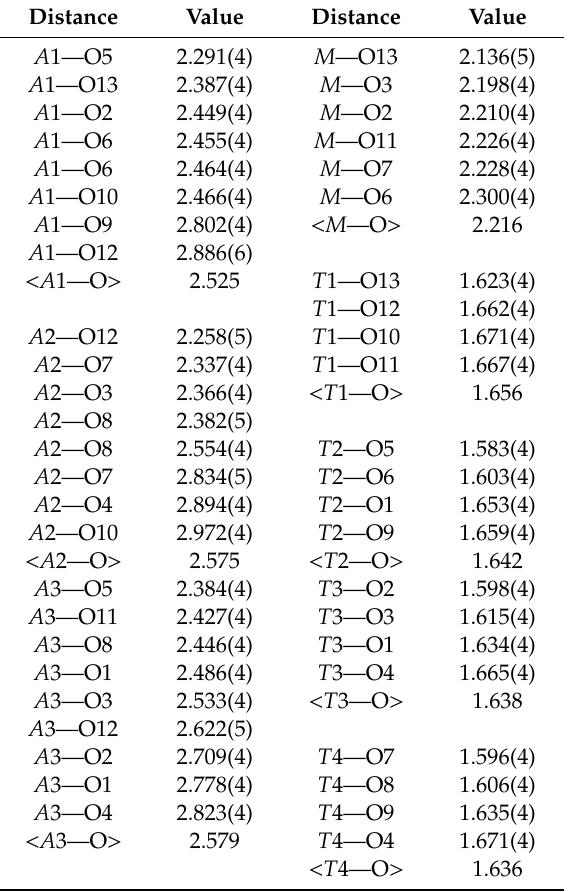
Table 7. Selected interatomic distances (Å) for